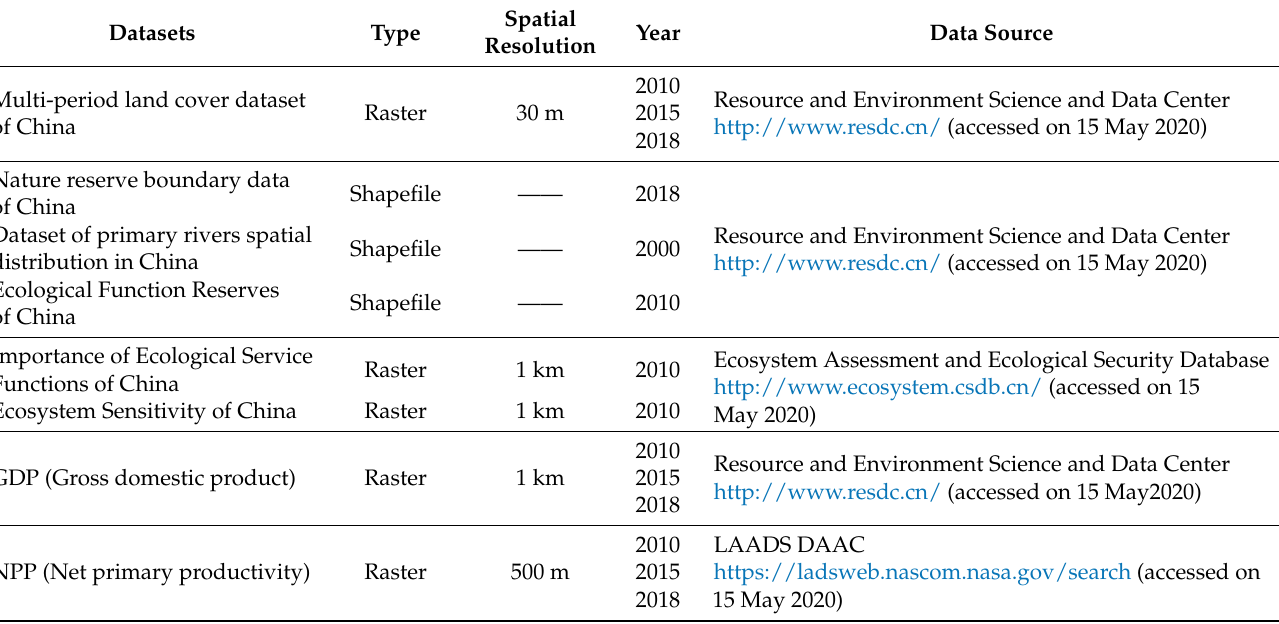
in Table 1. The MLC dataset was obtained by manual visual interpretation using Landsat remote sensing image data from the US. The land-use types include the six primary types of cropland, forestland, grassland, water, residential land, and unused land, and 25 secondary types. All raster datasets were resampled to 30 m by software Arcgis 10.2. As shown in Table 1, some datasets that are shared online publicly are limited due to temporal resolution. Table 1. Data sources for the “PLE Spaces” classification.